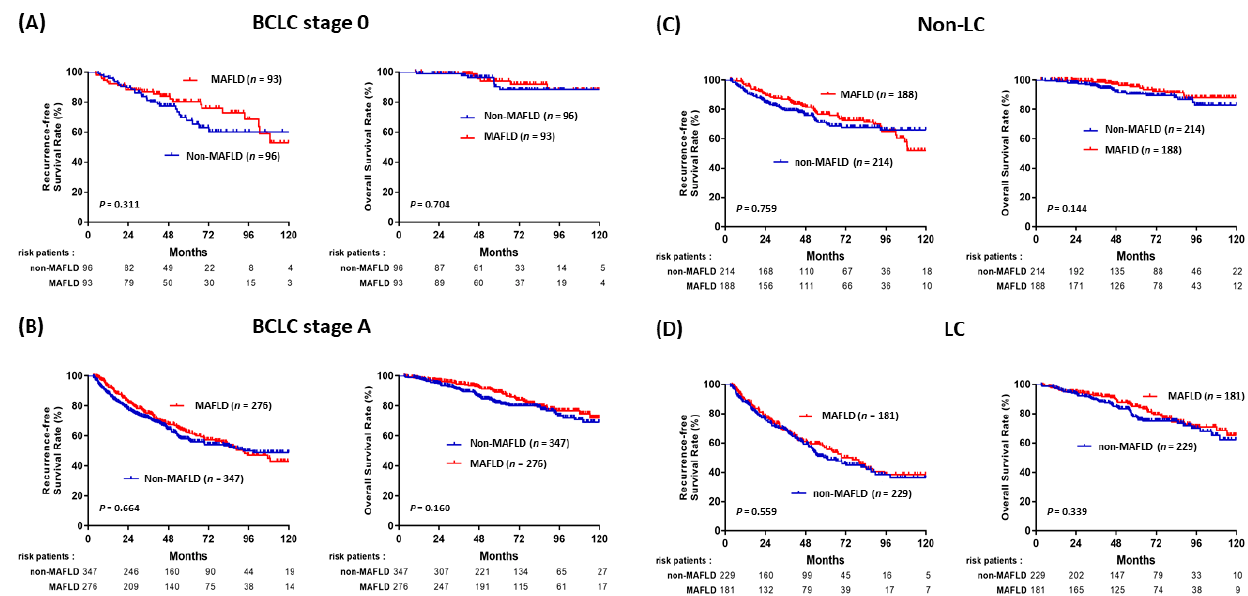
Figure 3. Comparisons of RFS and OS in HBV-HCC with or without MAFLD in the ( A ) BCLC stage 0, ( B ) BCLC stage A, ( C ) non-LC, and ( D ) LC subgroups.